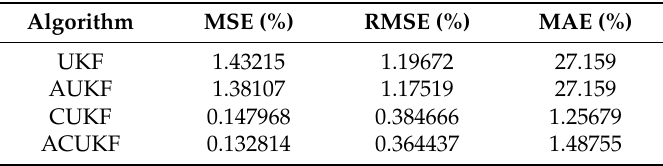
Figure 13. SOC estimate comparison using different methods under Gaussian mixture noise: ( a ) SOC estimation and reference results; ( b ) SOC estimate errors. Table 4. Evaluation results for different SOC estimation methods.